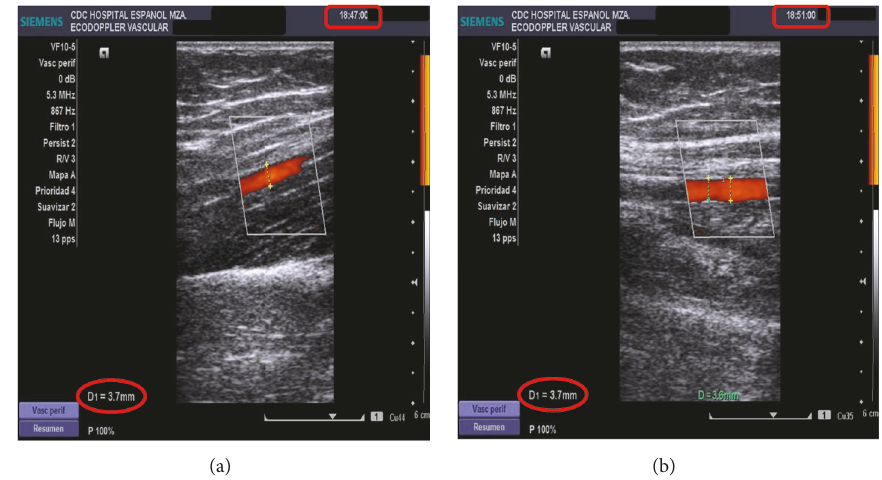
Figure 3: In FMD (flow-mediated dilation) in brachial artery patient did not present vascular reactivity in the first minute and this was interpreted as endothelial